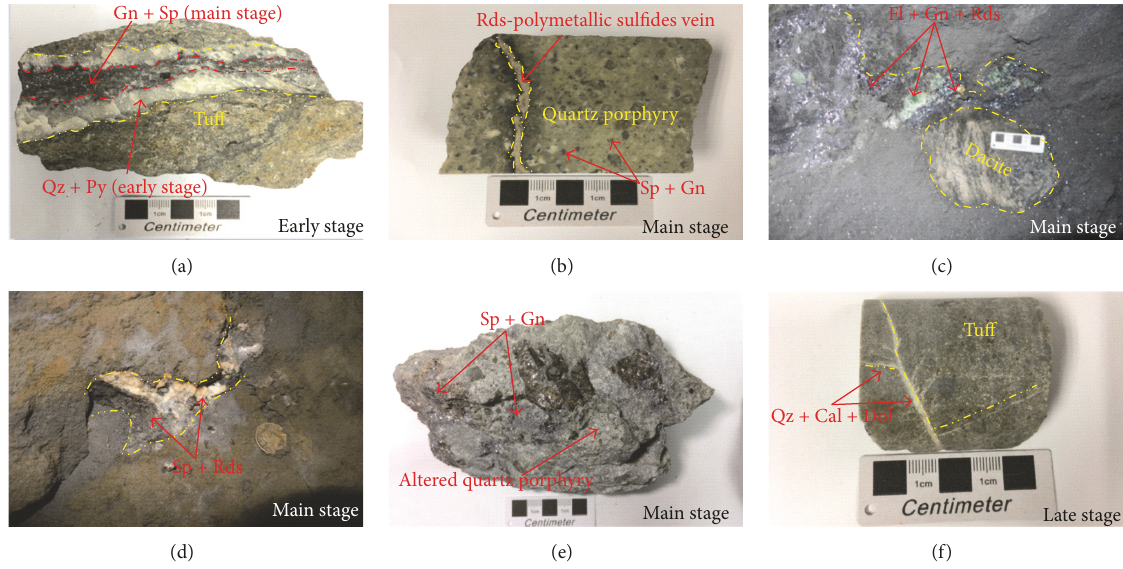
Figure 6: Photomicrographs showing three stages in the Zhijiadi deposit. (a) The early stage quartz-pyrite vein. (b) The main stage rhodochrosite polymetallic sulfides vein cross-cutting quartz porphyry and some sphalerite and galena disseminated in quartz porphyry. (c) The main stage fluorite-galena filling in the dacite breccia. (d) Coexistence of sphalerite and rhodochrosite in the hydrothermal breccia. (e) Brecciated sphalerite distributing in the altered quartz porphyry breccia. (f) The late stage quartz-carbonate vein cross-cutting the